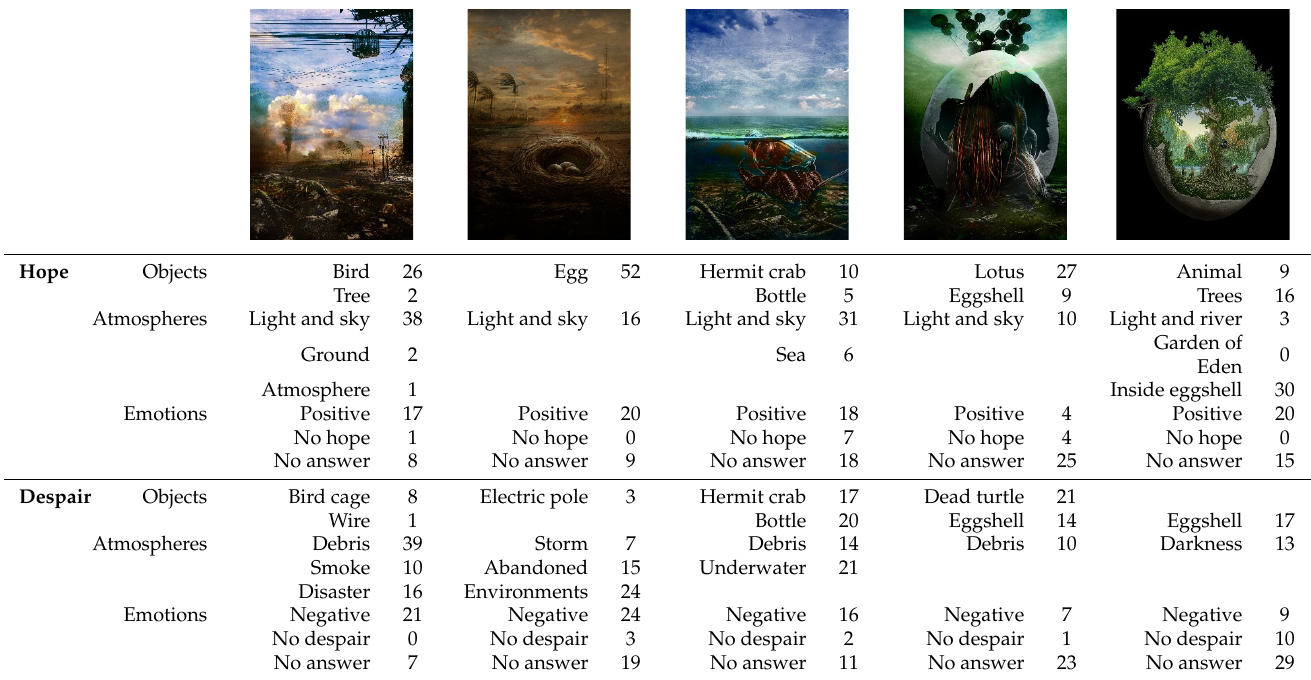
Table 6. Amount of comments on color images expressing hope and